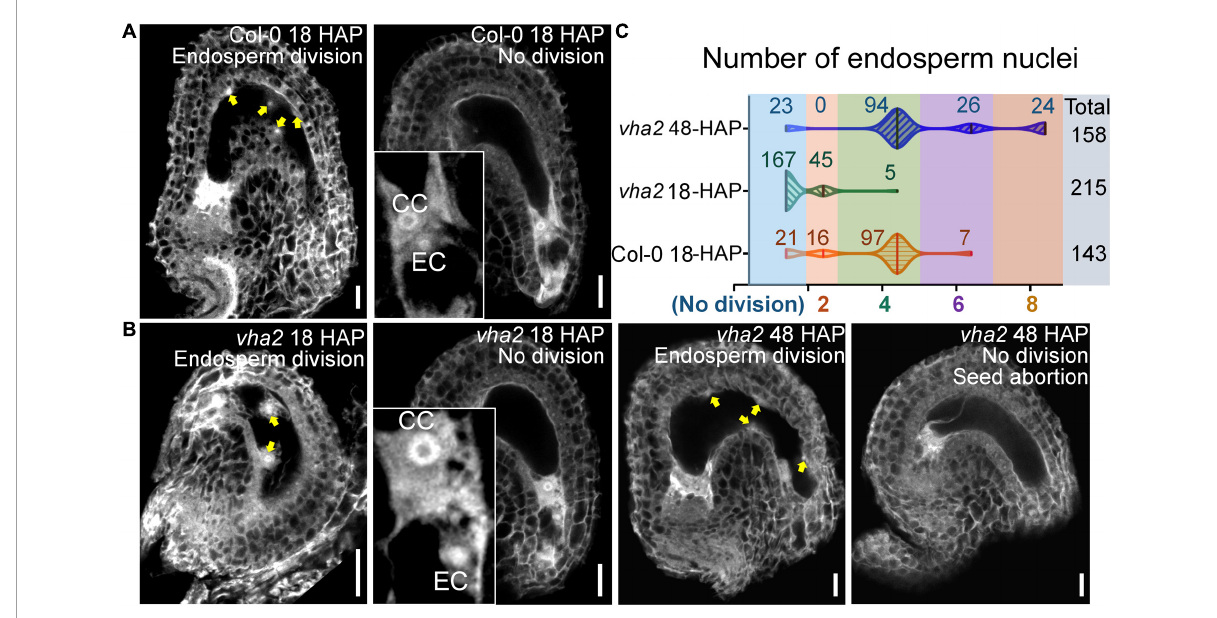
FIGURE5 Lack of V-ATPase affects the division rate of endosperm nuclei. (A) Endosperm nuclei of Col-0 seeds at 18 h after pollination (HAP). (B) Endosperm nuclei of vha2 seeds at 18 HAP and 48 HAP. Yellow arrows in (A,B) indicate the endosperm nuclei. EC egg cell, CC central cell, graphs represent typical phenotype of all samples. Bars = 20 µ m. (C) Quantitative analysis of endosperm nuclei number in Col-0 and vha2. Seeds shown in the statistical graph come from 5 different inflorescence